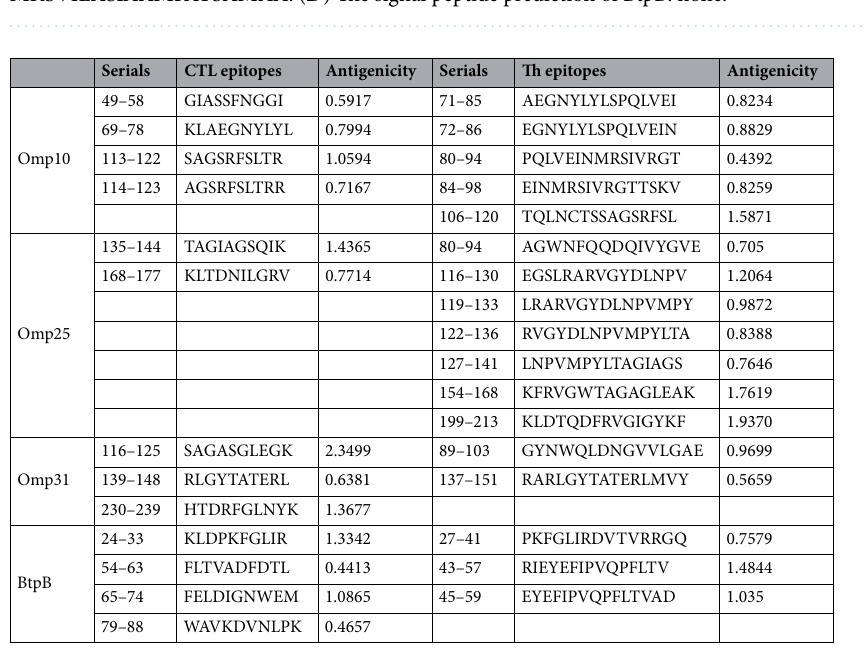
Figure 3. ( A–D ) Signal peptide of proteins using SignalP-5.0 analysis. SP (Sec/SPI): type of signal peptide predicted; CS: the cleavage site; Other: the probability that the sequence does not have any kind of signal peptide. ( A ) The signal peptide prediction of Omp10: MKRFRIVAPLALMSLALAAC. ( B ) The signal peptide prediction of Omp25: MRTLKSLVIVSAALLPFSATAFAA. ( C ) The signal peptide prediction of Omp31: MKSVILASIAAMFATSAMAA. ( D ) The signal peptide prediction of BtpB: none.